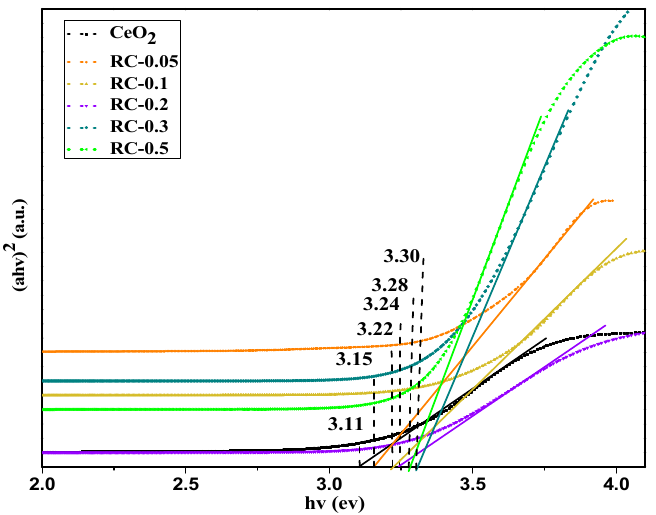
Figure 7. Plot of ( α hv) 2 versus photon energy for the CeO 2 NPs and CeO 2 NPs dispersed in the RC matrix.